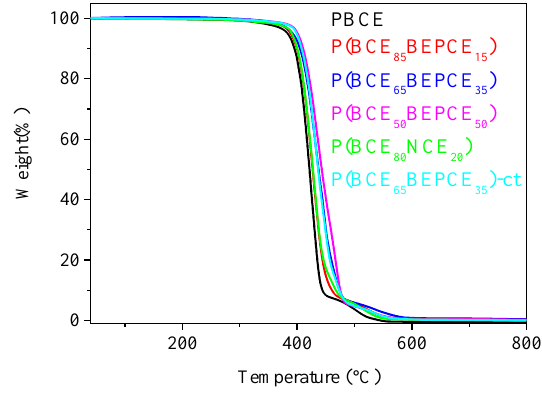
Figure 4. TGA traces of PBCE homopolymer and P(BCE m BEPCE n ) and P(BCE 80 NCE 20 ) random copolymers. Table 3 . Thermal characterization data of PBCE homopolymer and P(BCE m BEPCE n ) and P(BCE 80 NCE 20 ) random copolymers.